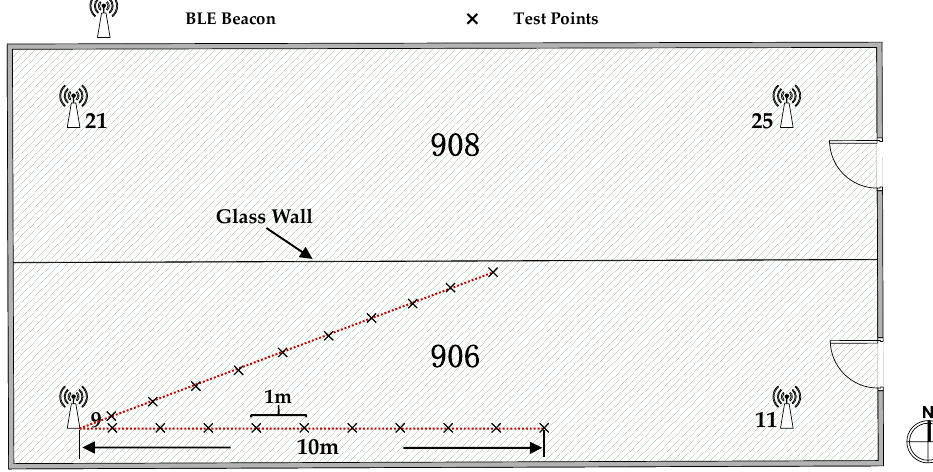
Figure 9. Experimental environment for Test bed 1.